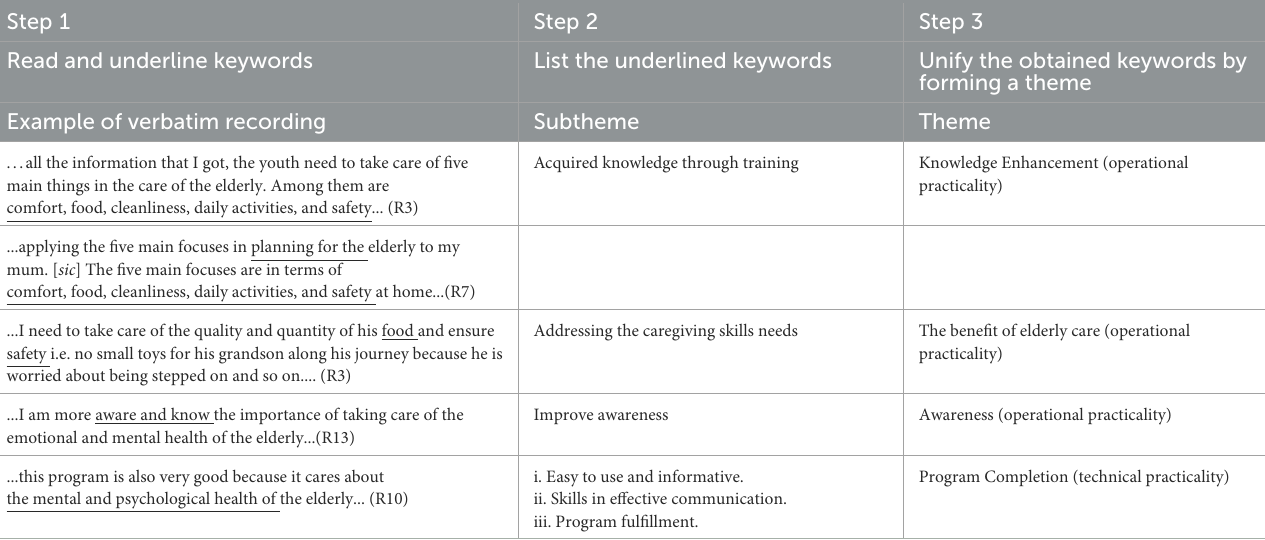
TABLE 2 Flow of thematic data